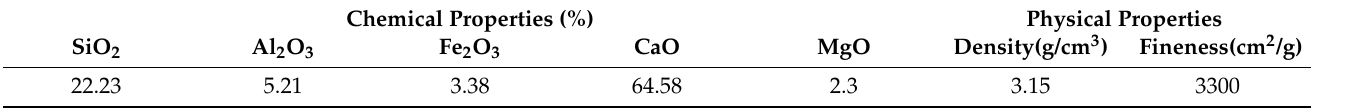
Table 1. Chemical and physical properties of ordinary Portland cement